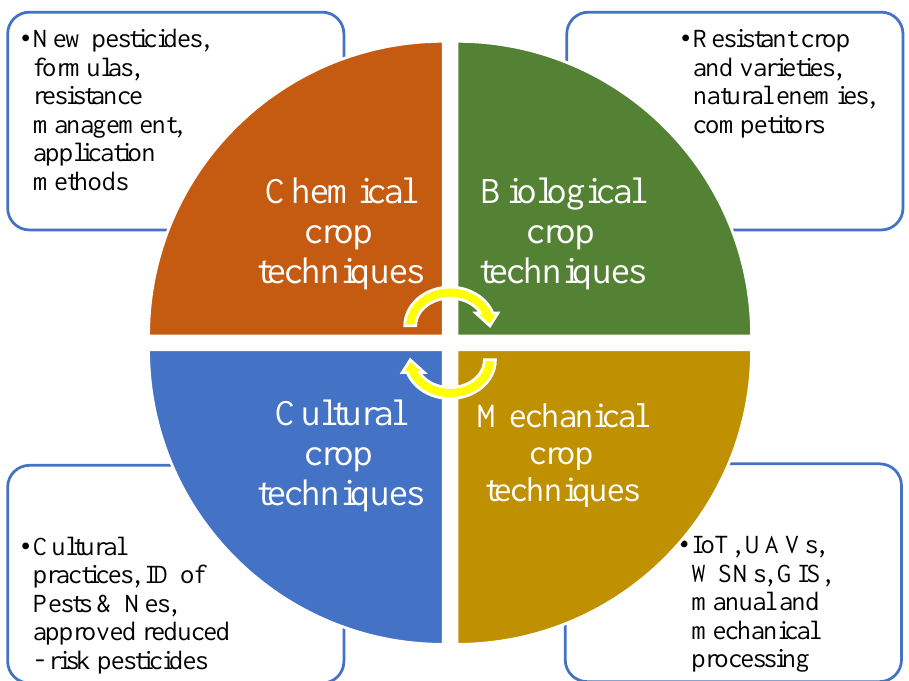
Figure 2. Preventative practices for crop protection. Source: Authors ’ own work (2022).